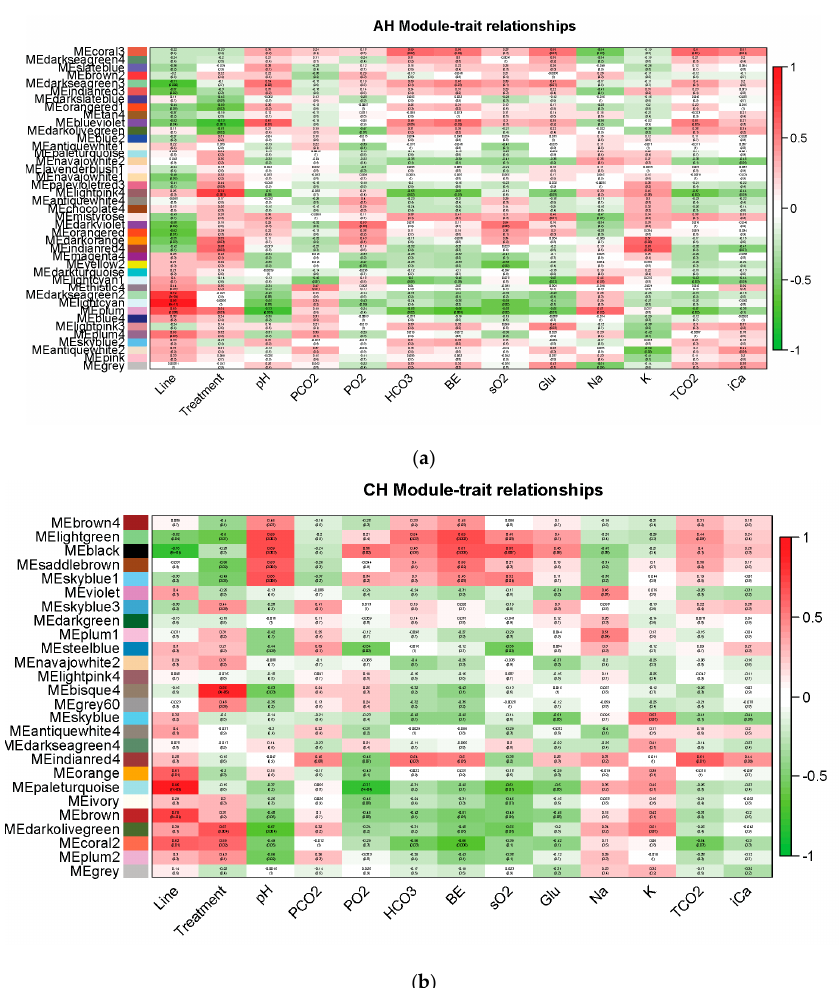
Figure 9. Module-trait relationships from WGNCA. Each module ( y -axis) is correlated with each phenotype ( x -axis) and the correlation and p -values were reported for each comparison. Strong positive correlations are colored in red, and strong negative correlations are colored in green. ( a ) Acute heat stress ( b ) Chronic heat stress and NDV infection.